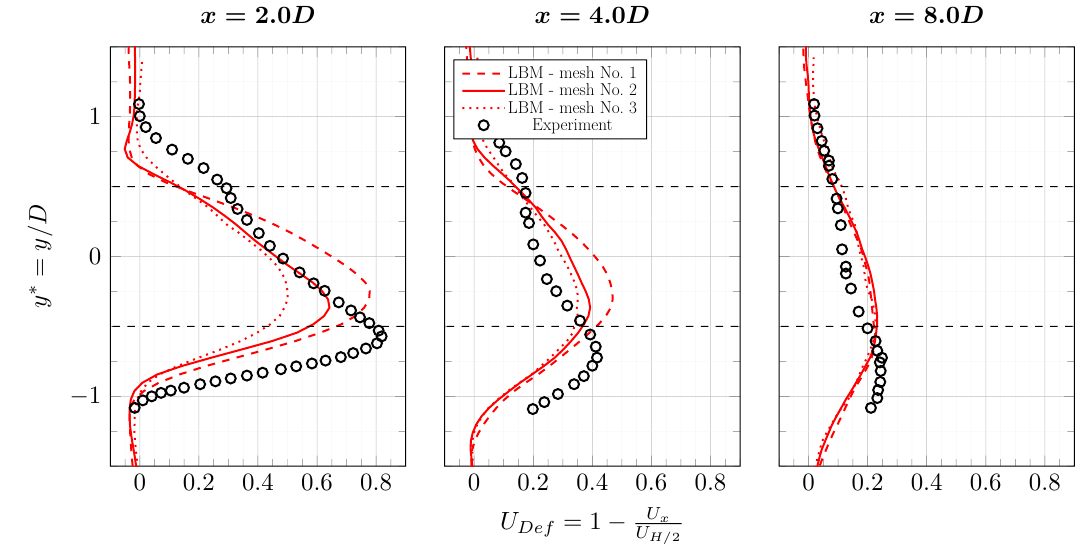
Figure 7. Average axial velocity deficit y profiles in the wake of the tidal turbine [27] at TSR = 1.1: experimental data and ALM-LBM results for the three meshes. Turbine footprint is drawn in horizontal black dashed-lines.